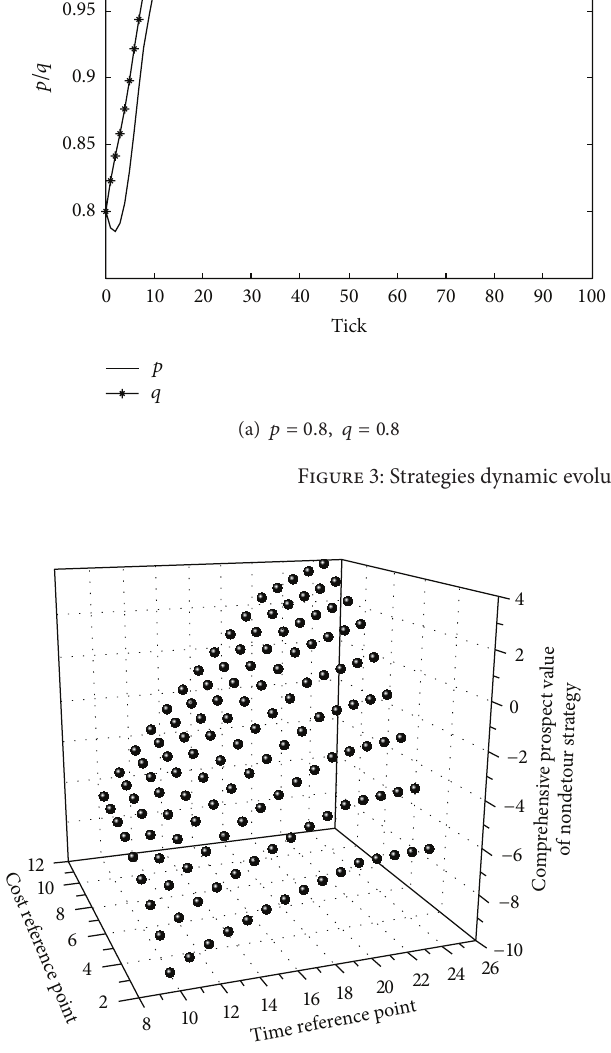
Figure 4: Comprehensive prospect values of different reference points for nondetour strategy.